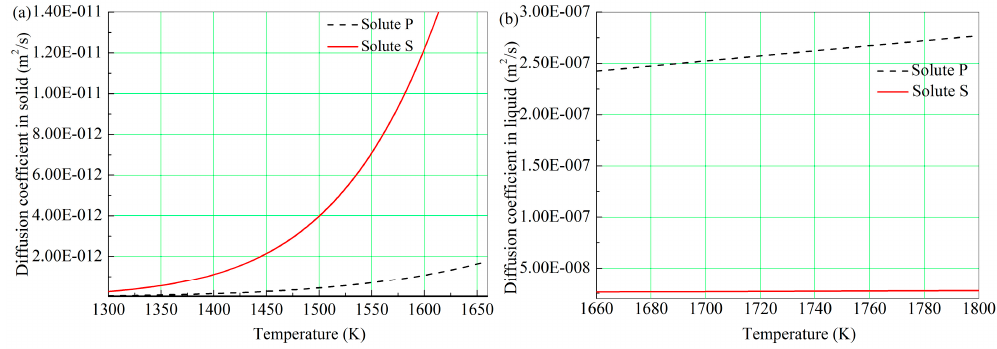
Figure 15. Diffusion coefficients in both the liquid and solid for the solutes P and S: ( a ) solid zone; and ( b ) liquid zone.